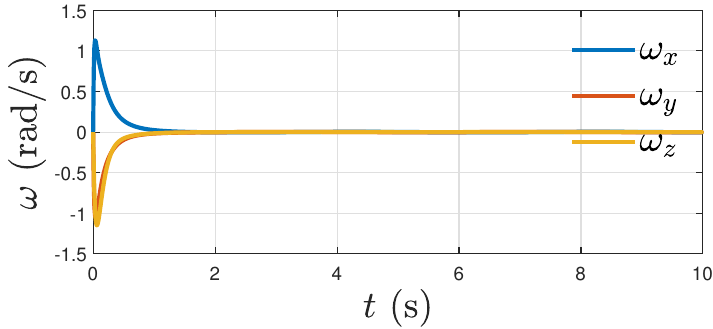
Figure 13. Angular velocity tracking error versus time for D =